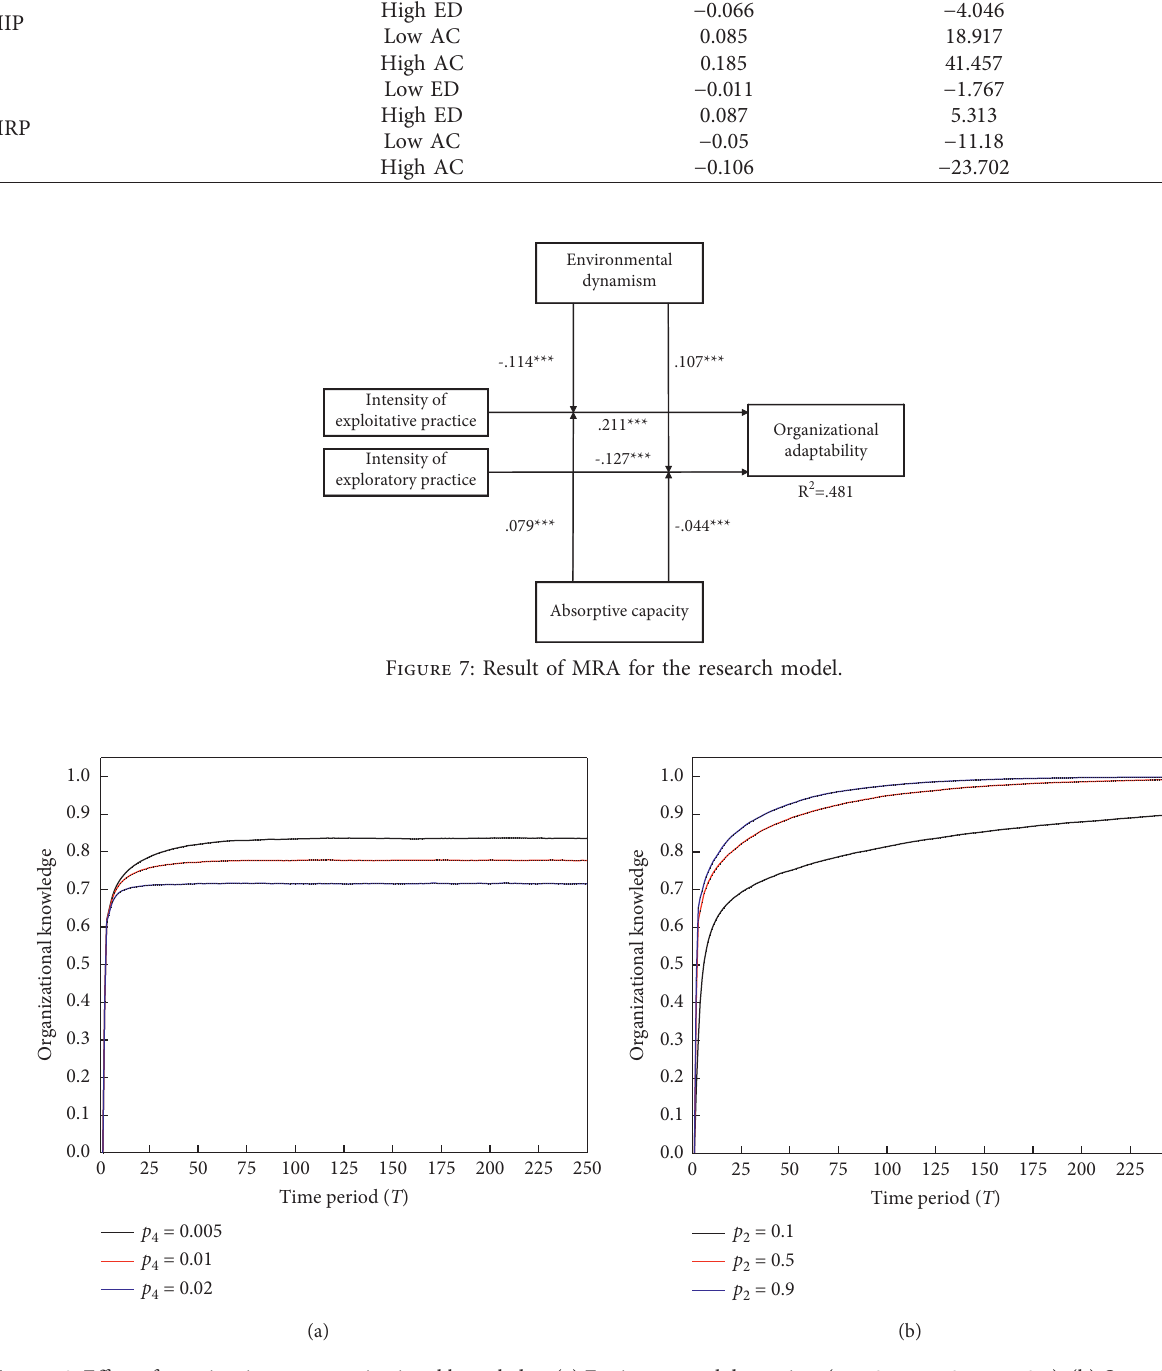
� 0.5, p � 0.5, p � 0.5). (b) Organizational 1 2 3